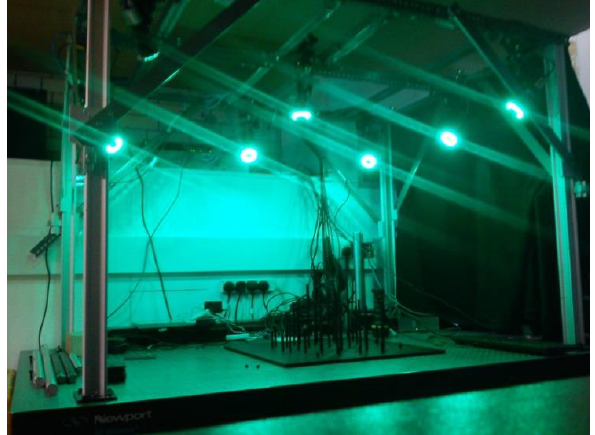
Figure 6. Small calibration